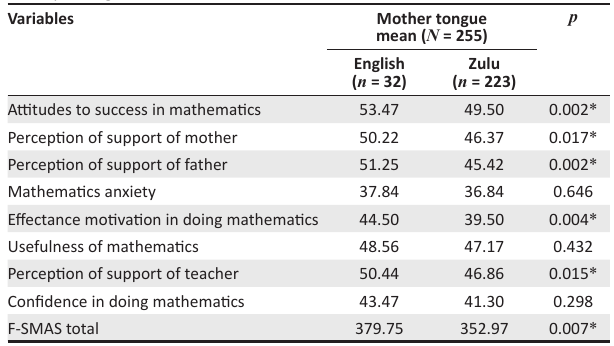
TABLE 4: Differences in attitudes towards mathematics between English- and Zulu-speaking students.